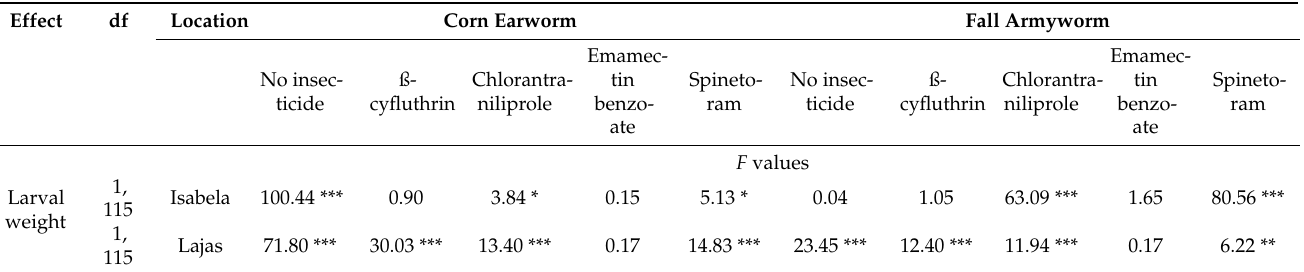
Table 6. Simple analysis of variance for the weight of corn earworm ( Helicoverpa zea (Boddie) (Lepidoptera: Noctuidae)) and fall armyworm ( Spodoptera frugiperda (J. E. Smith) (Lepidoptera: Noctuidae)) larvae evaluated at 96 h after insecticide application in 2019 and